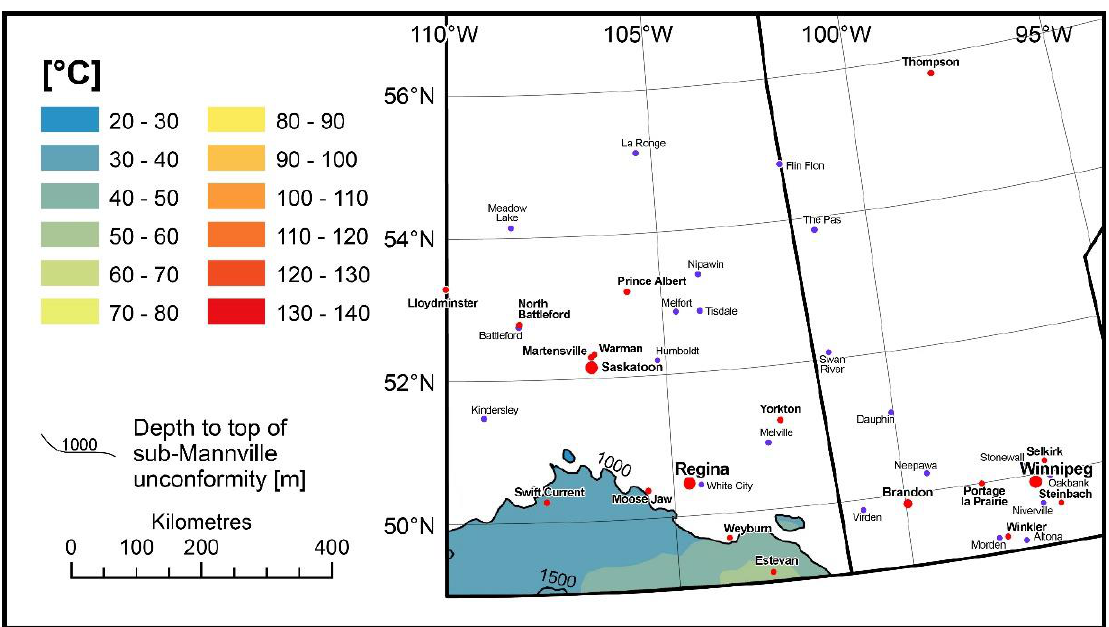
Figure A6. Temperatures top of sub-Mannville unconformity—Saskatchewan – Manitoba WCSB.